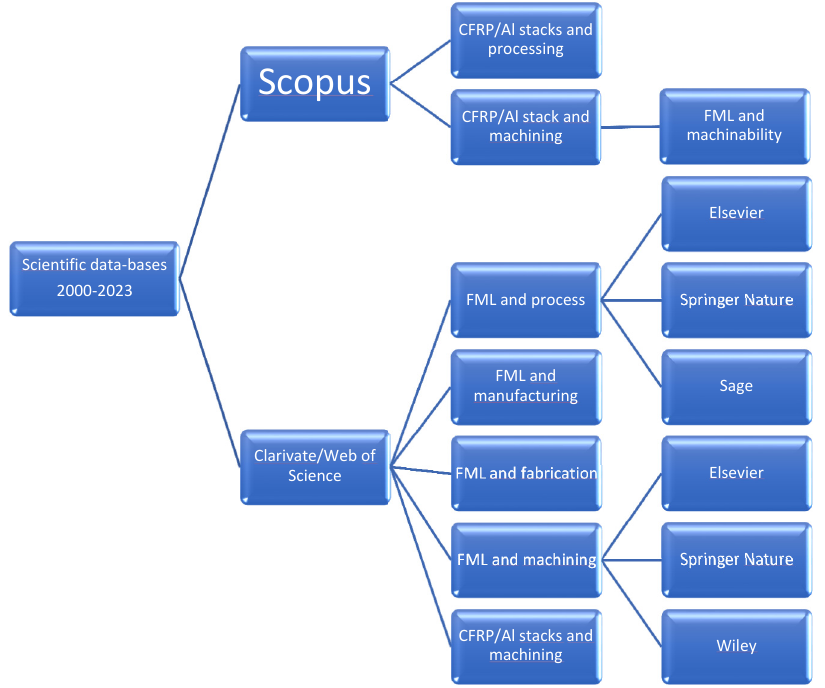
Figure 4. Route to reach best literature information about FML machining process.